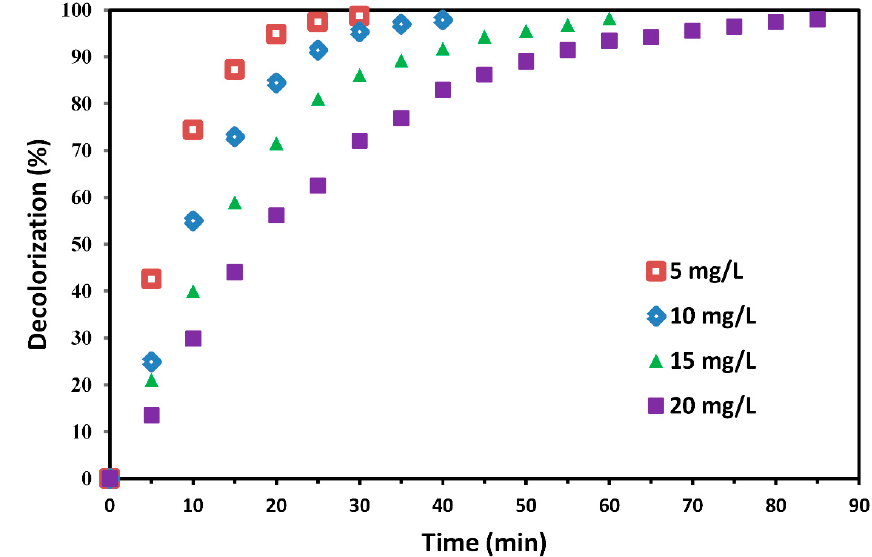
Figure 9. MG decolorization efficiency of TiO 2 -Ar catalyst at various initial dye concentrations; [H 2 O 2 ] = 13 mM.